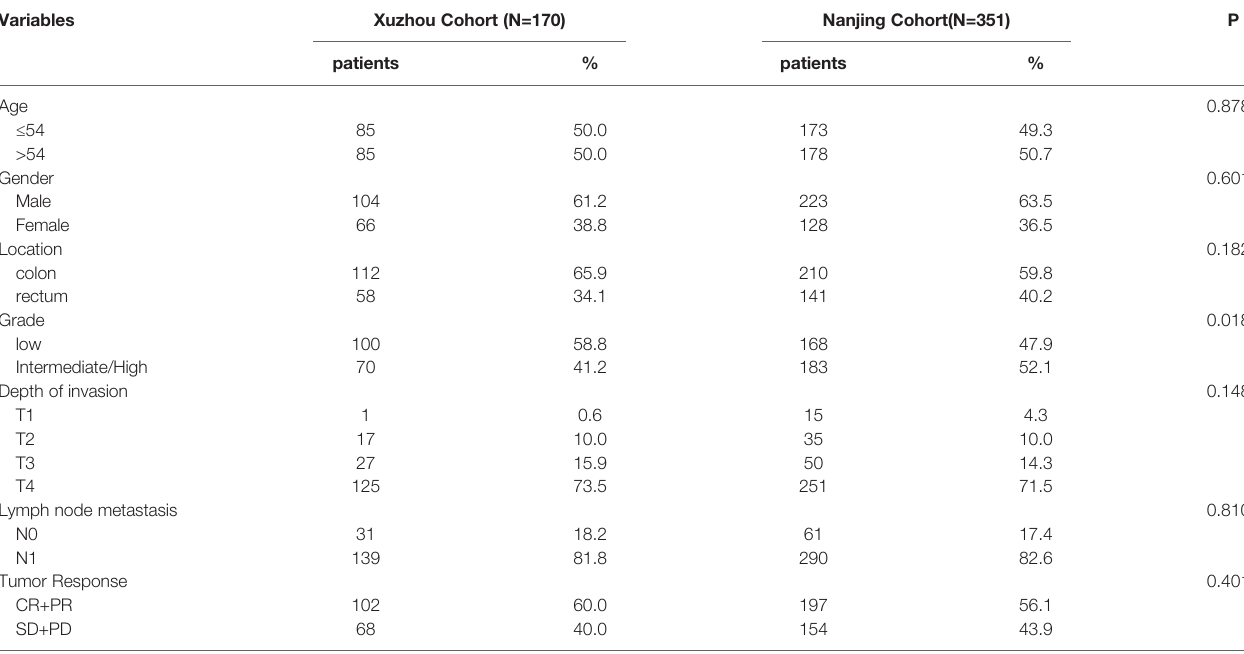
TABLE 1 | Frequency distribution of the selected variables in colorectal cancer patients.